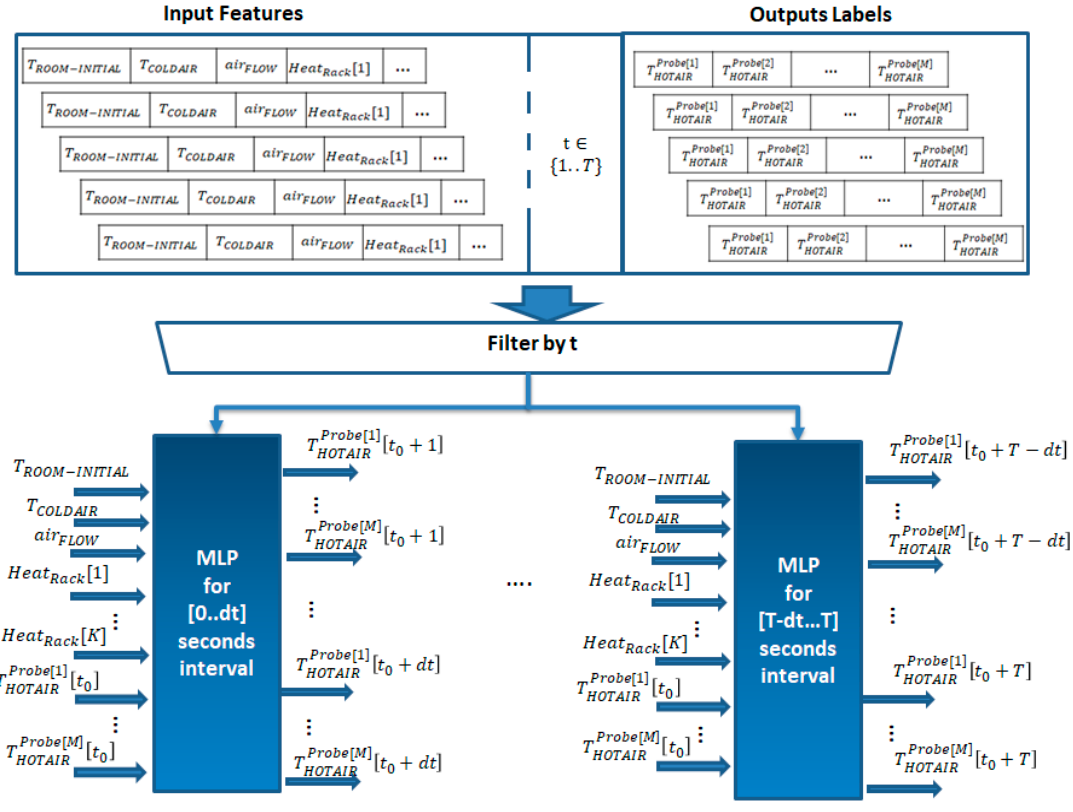
Figure 7. Structure of the neural network infrastructure and data set used in the forecasting process.